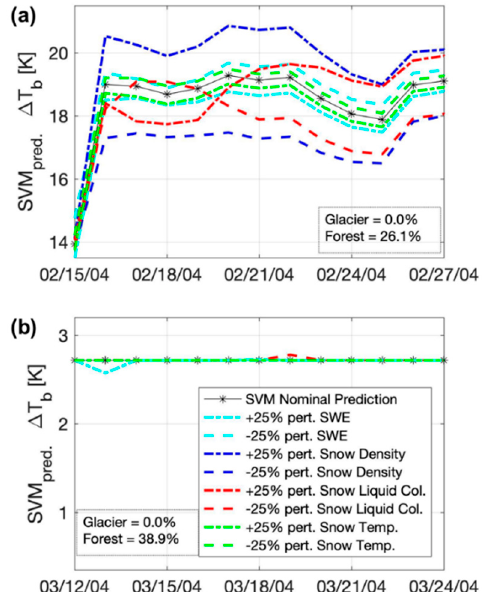
Figure 10. Examples of support vector machine (SVM) sensitivity associated with different perturbations about the nominal geophysical (snow) states (a: controllable case; b: uncontrollable case).4. Summary and Conclusions.